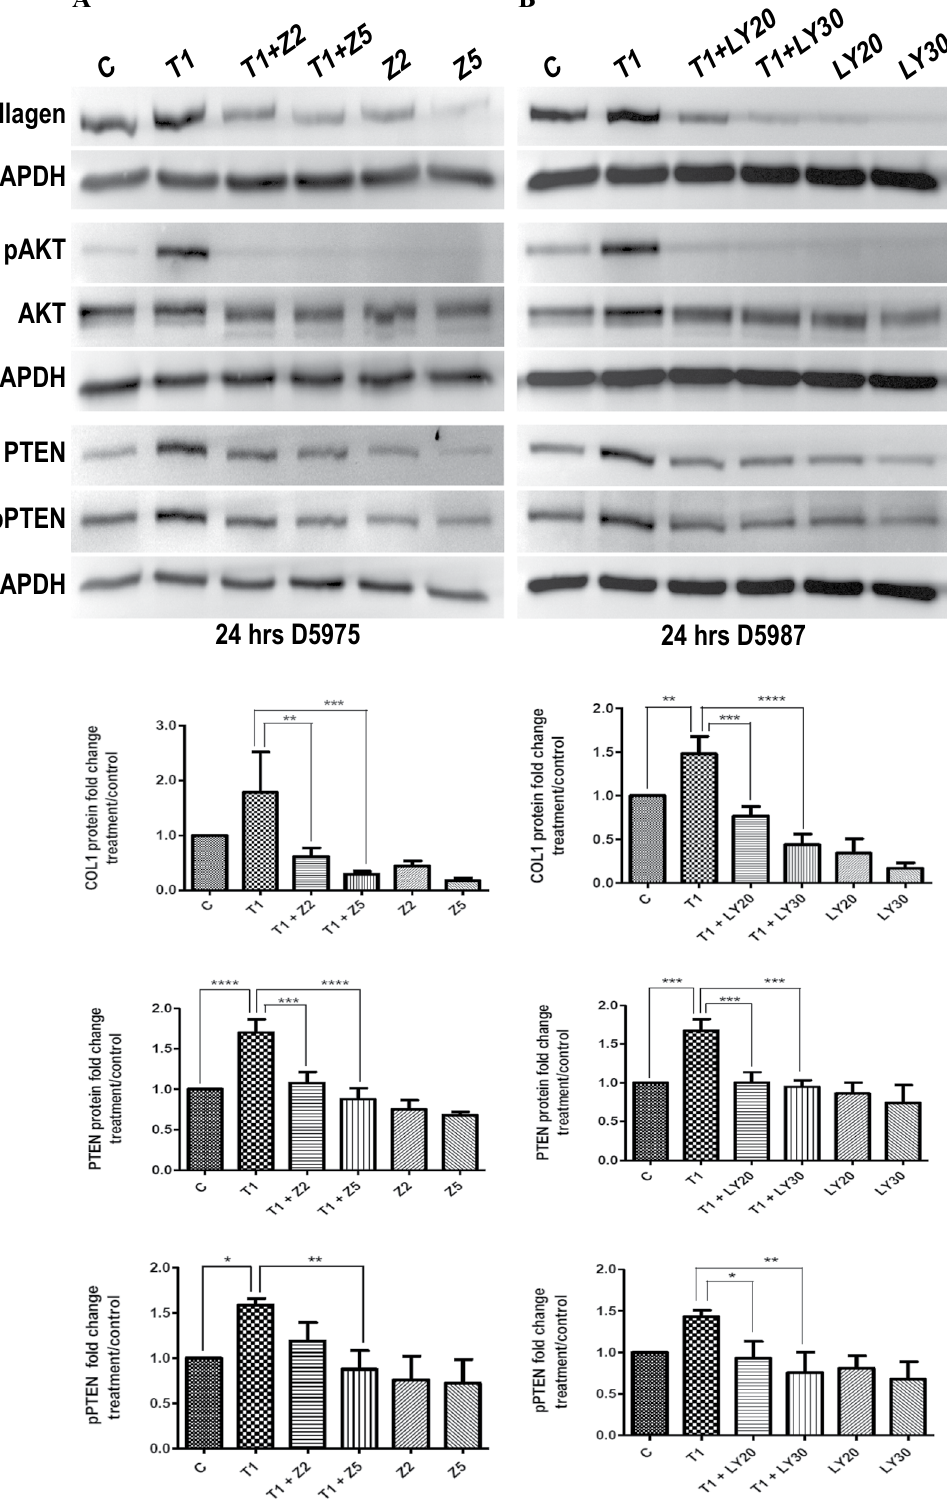
Figure 3. Inhibition of PI3-kinase/AKT signaling prevents TGF- β -induced increase in levels of collagen and PTEN/phosphorylation in human TM cells. ( A,B ) Human TM cells were treated with TGF- β 2 (1 ng/ml) and PI3- kinase signaling inhibited using ZSTK474 (Z2, Z5- 2 μ M or 5 μ M) or LY294002 (LY20, LY30- 20 μ M or 30 μ M). Protein was extracted at 24 h and collagen, PTEN, pPTEN (ser380/thr382/383), AKT and pAKT detected by Western blot. Densitometry was performed on collagen, PTEN and pPTEN Western blots using ImageJ software and shown as graphs. Statistical significance was determined using one-way ANOVA with Tukey’s post-hoc. * p < 0.05, ** p < 0.01, *** p < 0.001, **** p < 0.0001. N = 3. D5975, D5987- representative human